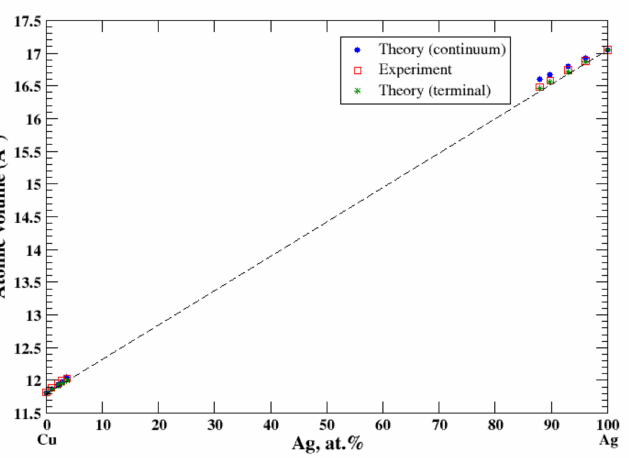
Figure 7. Atomic volume vs. concentration for Ag-Cu alloy system. The experimental data are from Ref. [16] (p. 279 and p.